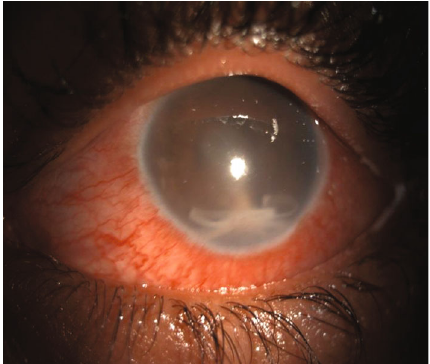
Figure 1: Clinical picture of the a ff ected eye. Note the hazy cornea, circumciliary congestion, and the worm along with exudates in the inferior